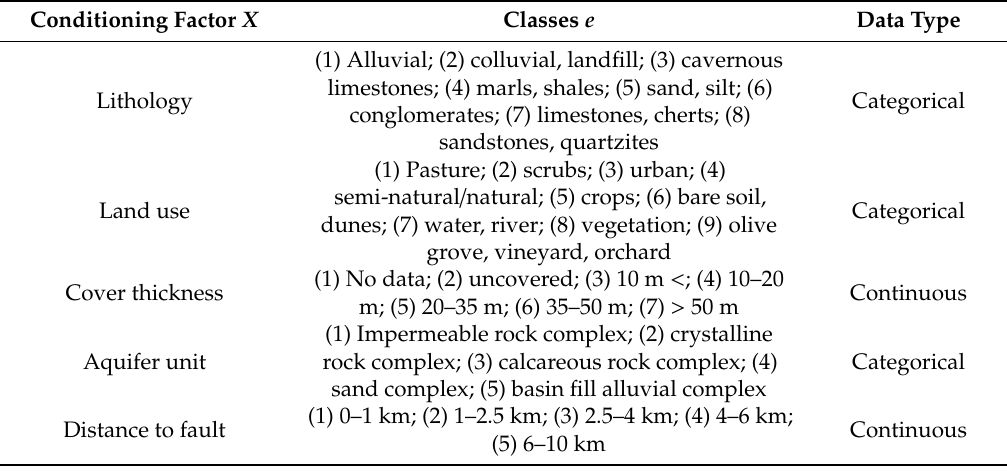
Table 2. Ground subsidence conditioning factors X and their